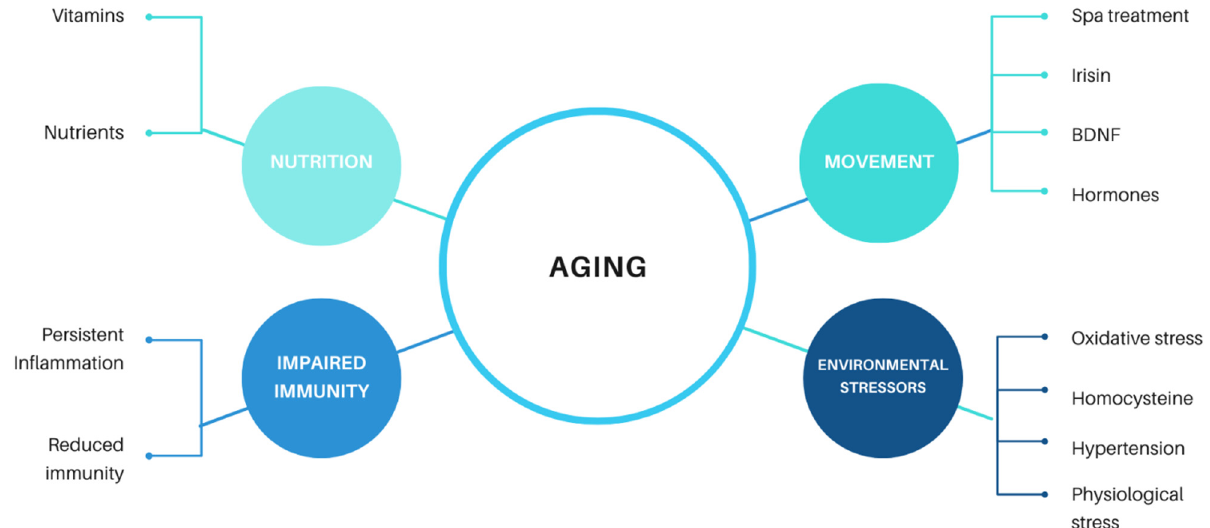
Figure 1. Factors influencing aging .